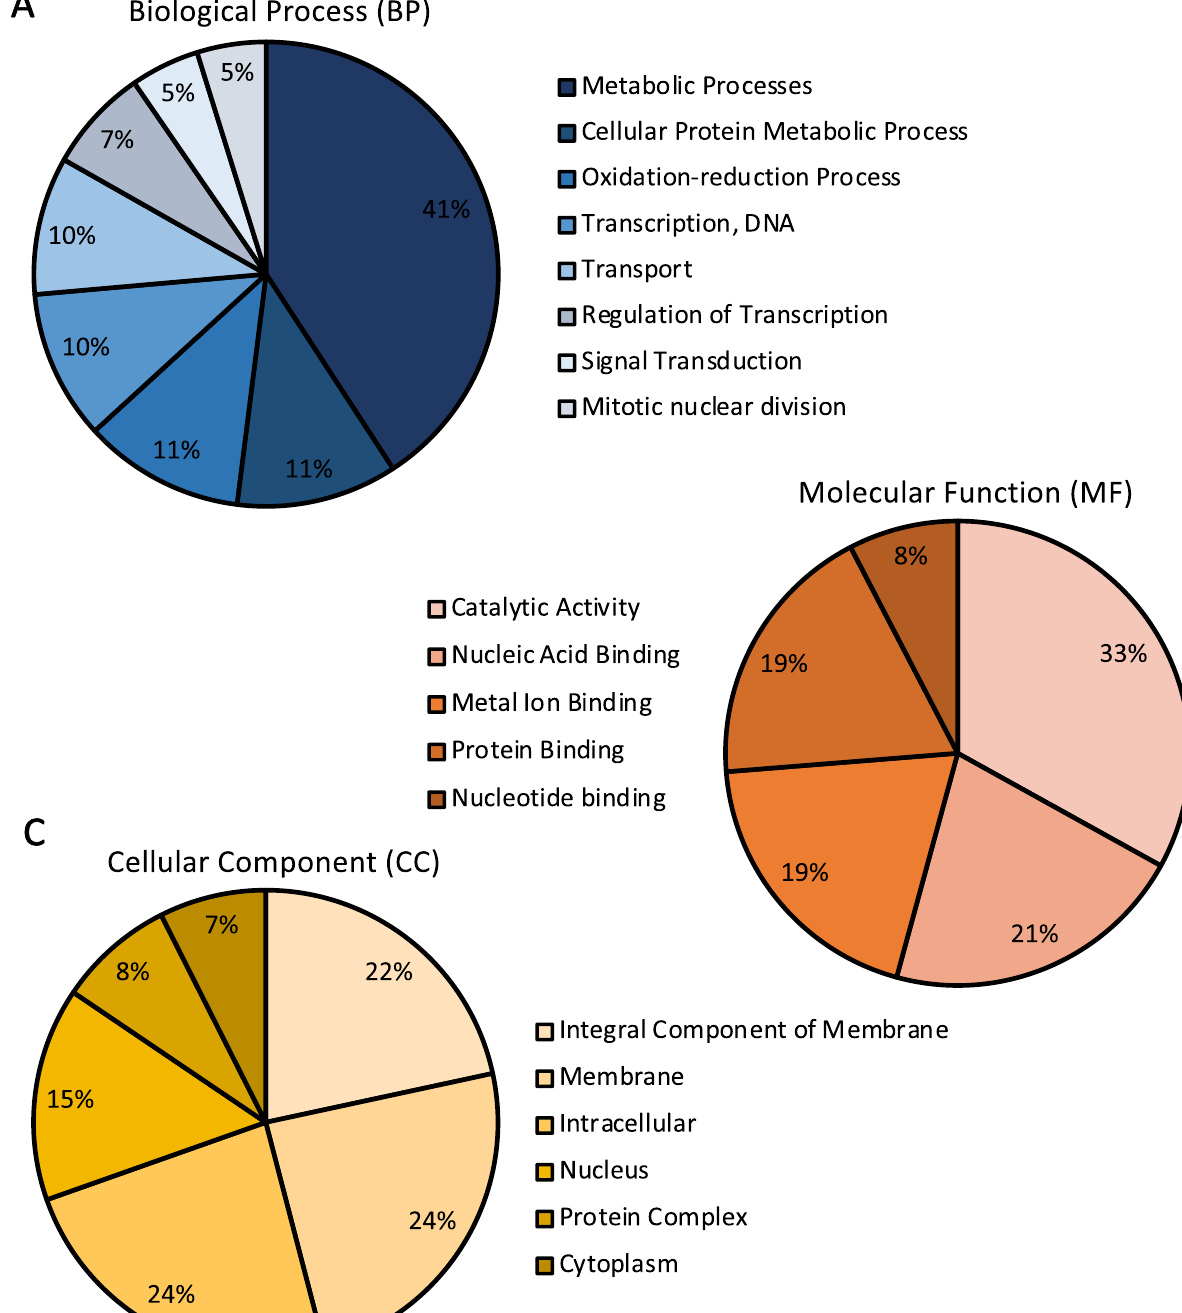
Figure 2. Blast2GO Gene Ontology of DEGs arranged by functional categories. (A) Biological processes (BP), (B) molecular function (MF), and (C) cellular component (CC). The predicted gene functions of differentially expressed genes as assigned by Blast2GO at level 2–3 in each aforementioned category. Each DEG may be assigned to one or more GOterm, with a total of 391 GOterms from the three functional groups assigned to the 134